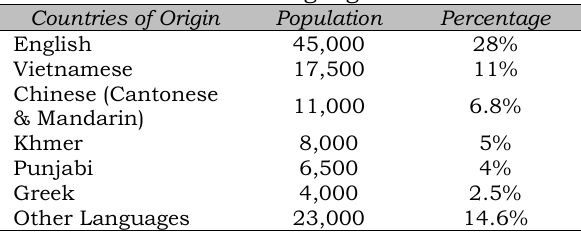
Table 2. Language Use